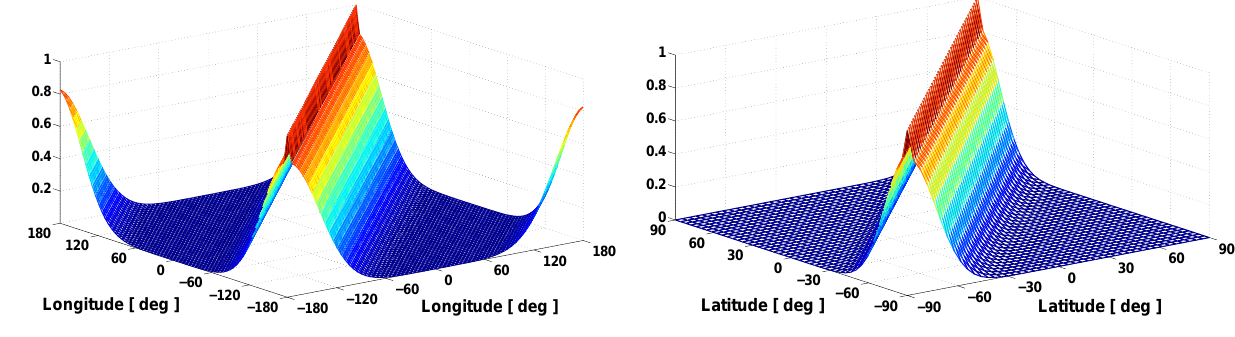
Fig. 1. Mesh representation of the one-dimensional longitudinal and latitudinal correlation matrices. The latitude-longitude model grid resolution is 4 ◦ × 5 ◦ (about 400km × 500km near the equator) and the correlation lengths are ‘ x = 1500km and ‘ y = 1200km.